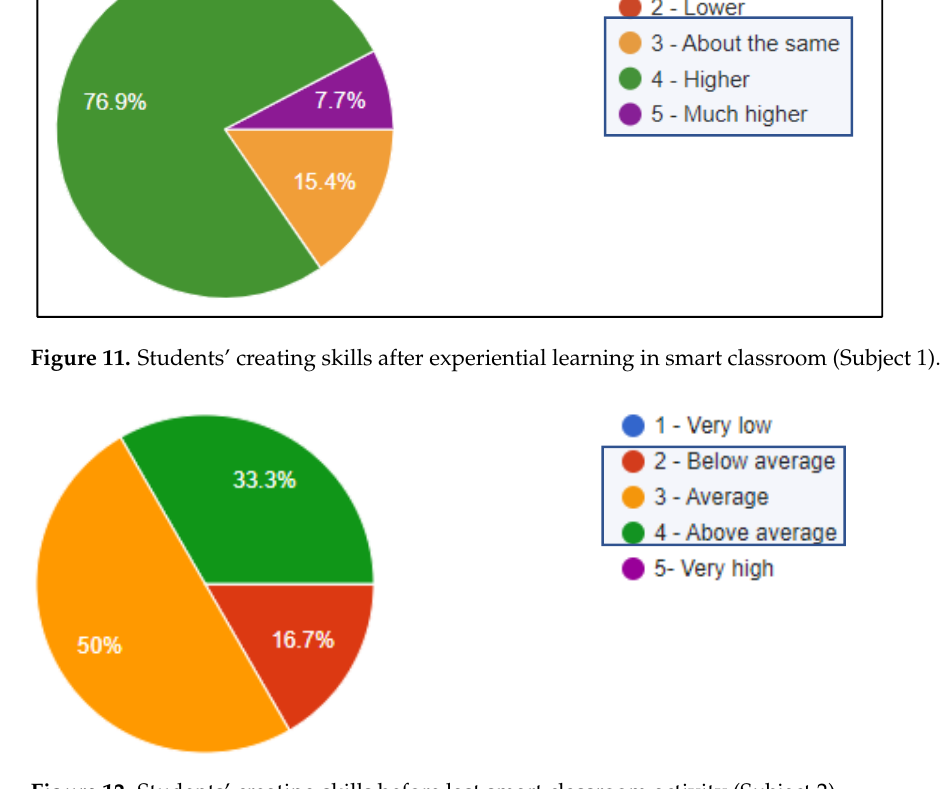
Figure 12. Students’ creating skills before last smart classroom activity (Subject 2).